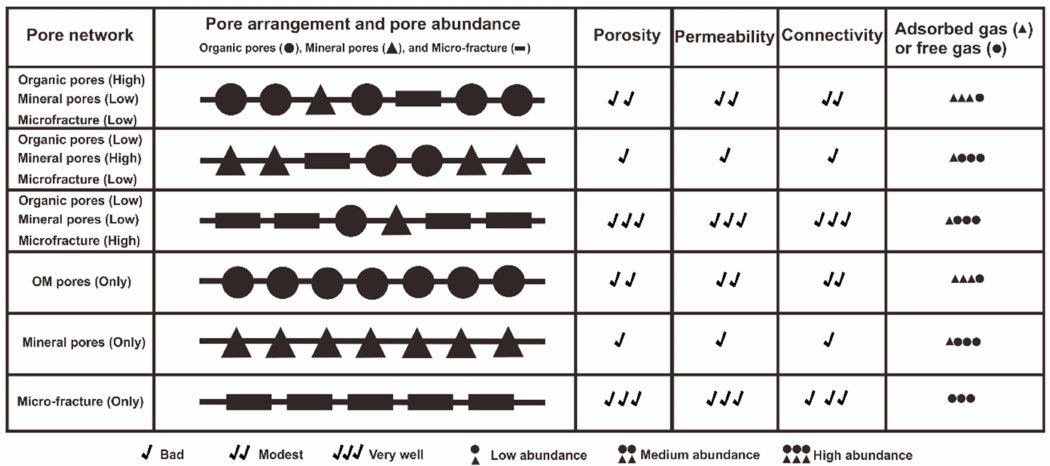
Figure 13. Quantitative and qualitative description of hypothetical relationships between arrangement and abundance of three di ff erent pore types and porosity, permeability, connectivity, as well as gas storage